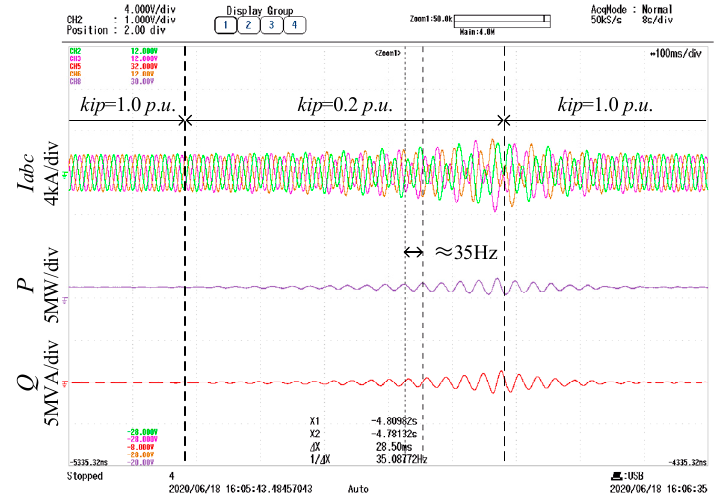
Figure 10. Waveforms of system current and active and reactive power when k ip decreases.